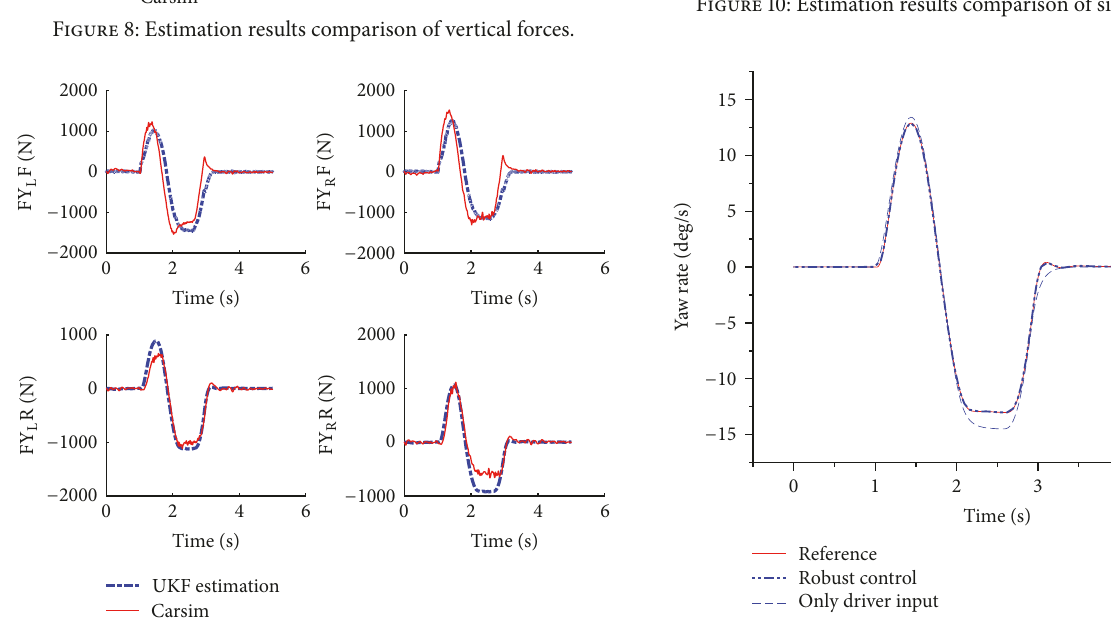
Figure 9: Estimation results comparison of tire lateral forces.